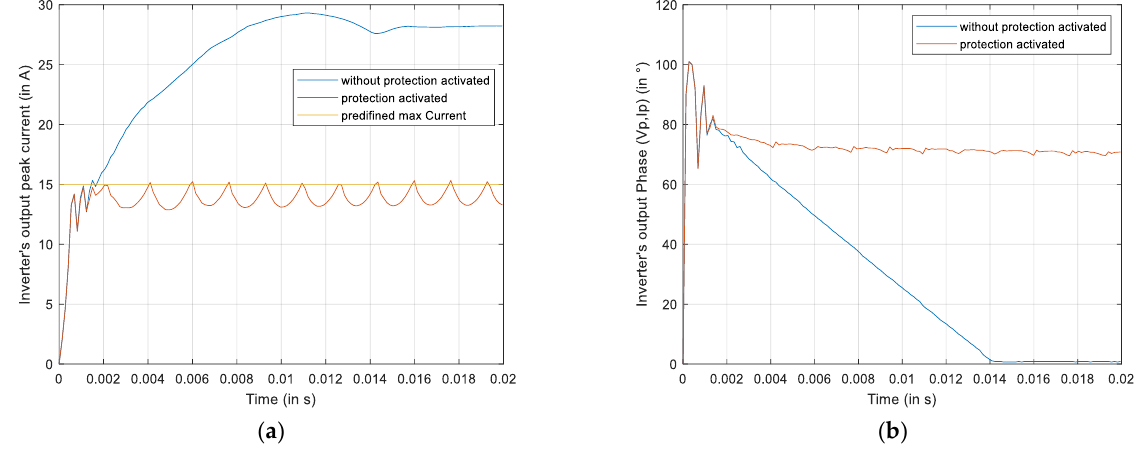
Figure 14. ( a ) Value of 𝐼 𝑝 [A] with and without current limitation control at 15 A; ( b ) value of 𝜑 𝑝 [°] with and without current limitation control at 15 A.